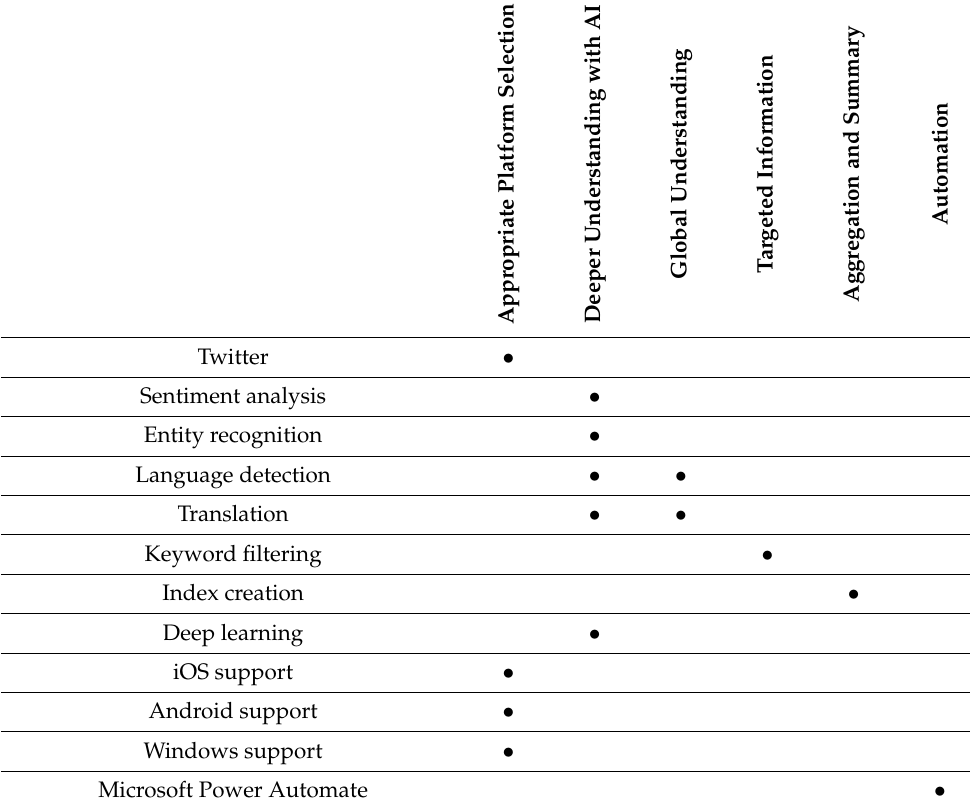
Table 4. Mapping between solutions and